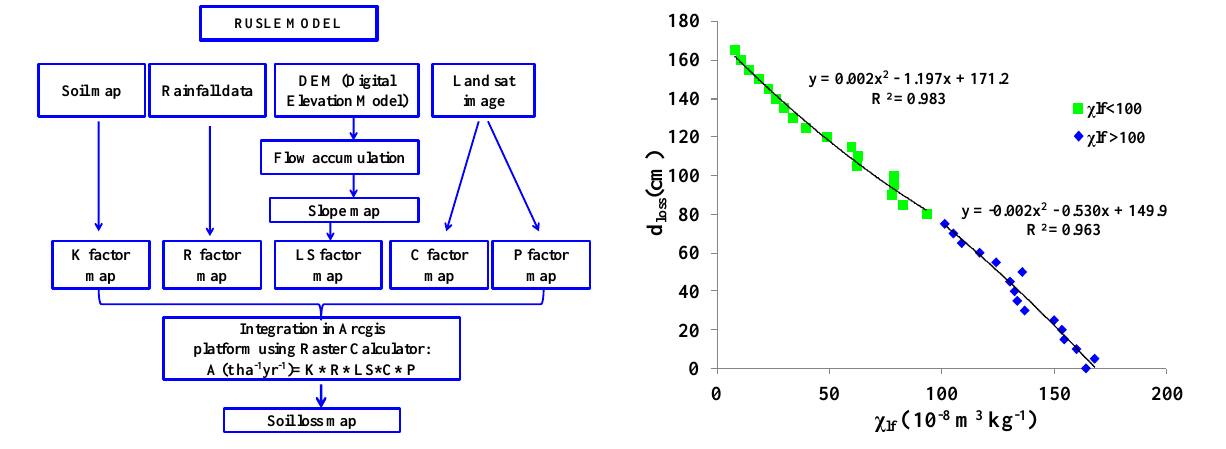
Figure 4. Predictive curve obtained by T-H model showing the polynomial relations correlating the soil loss (in cm) to measured χ lf in reference soil after tillage homogenization (T- H